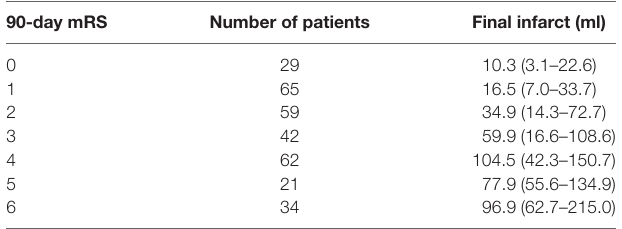
Table 1 | Median final infarct sizes with interquartile ranges 24 h after the stroke in the seven modified Rankin scale (mRS) groups. 90-day mrs number of patients Final infarct